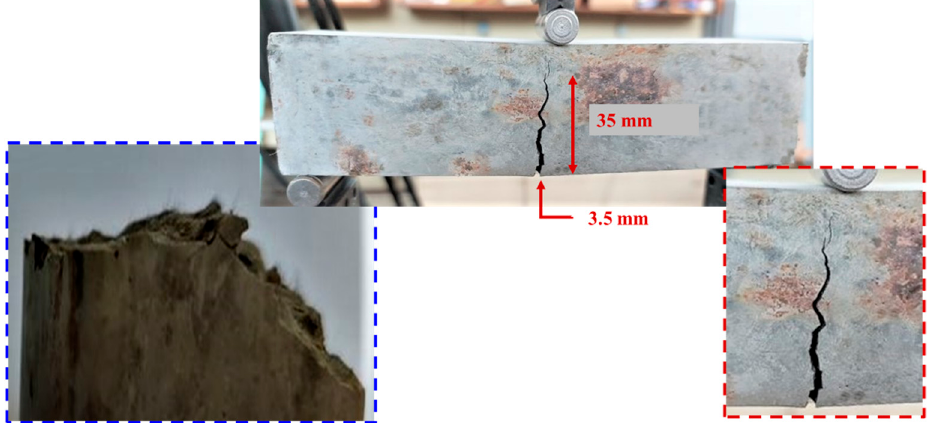
Figure 12. Crack width and length after bending test and CFs concentration at the rupture interface in the case of wet mixing of CFs adding SP and using 60 min sonication.